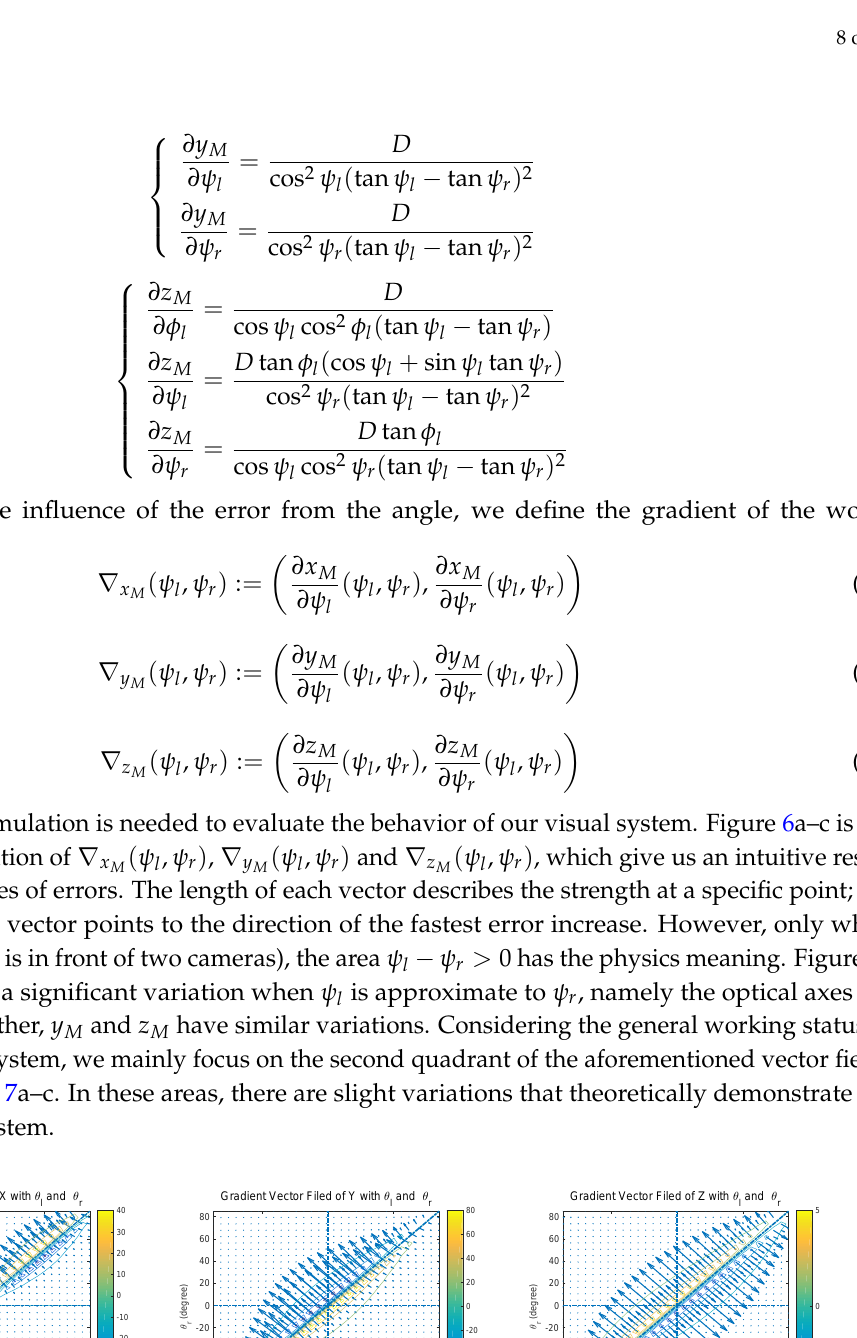
( ψ ) and ( c ) ∇ z l , ψ r M